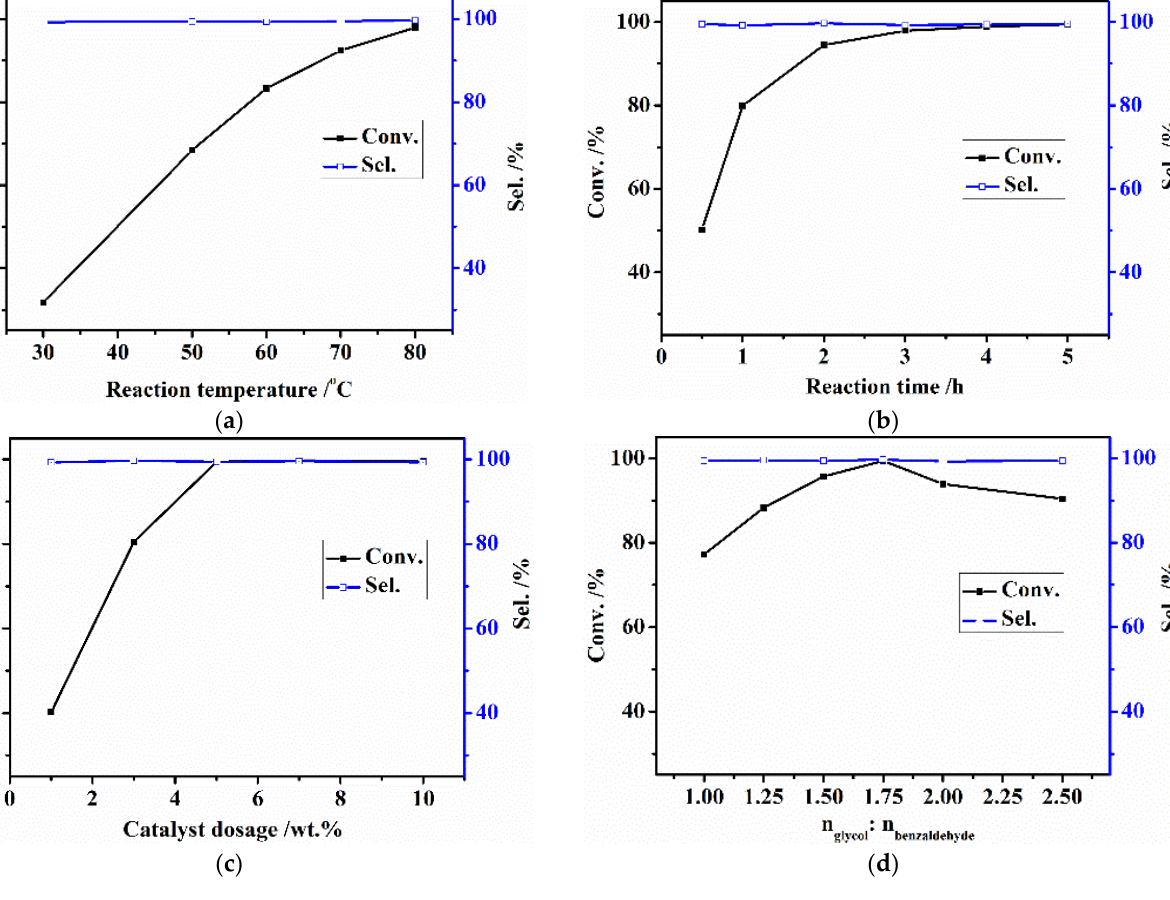
Figure 8. Effect of reaction conditions on benzaldehyde conversion. ( a ) Reaction temperature; ( b ) reaction time; ( c ) catalyst dosage; ( d ) molar ratio of glycol/benzaldehyde.